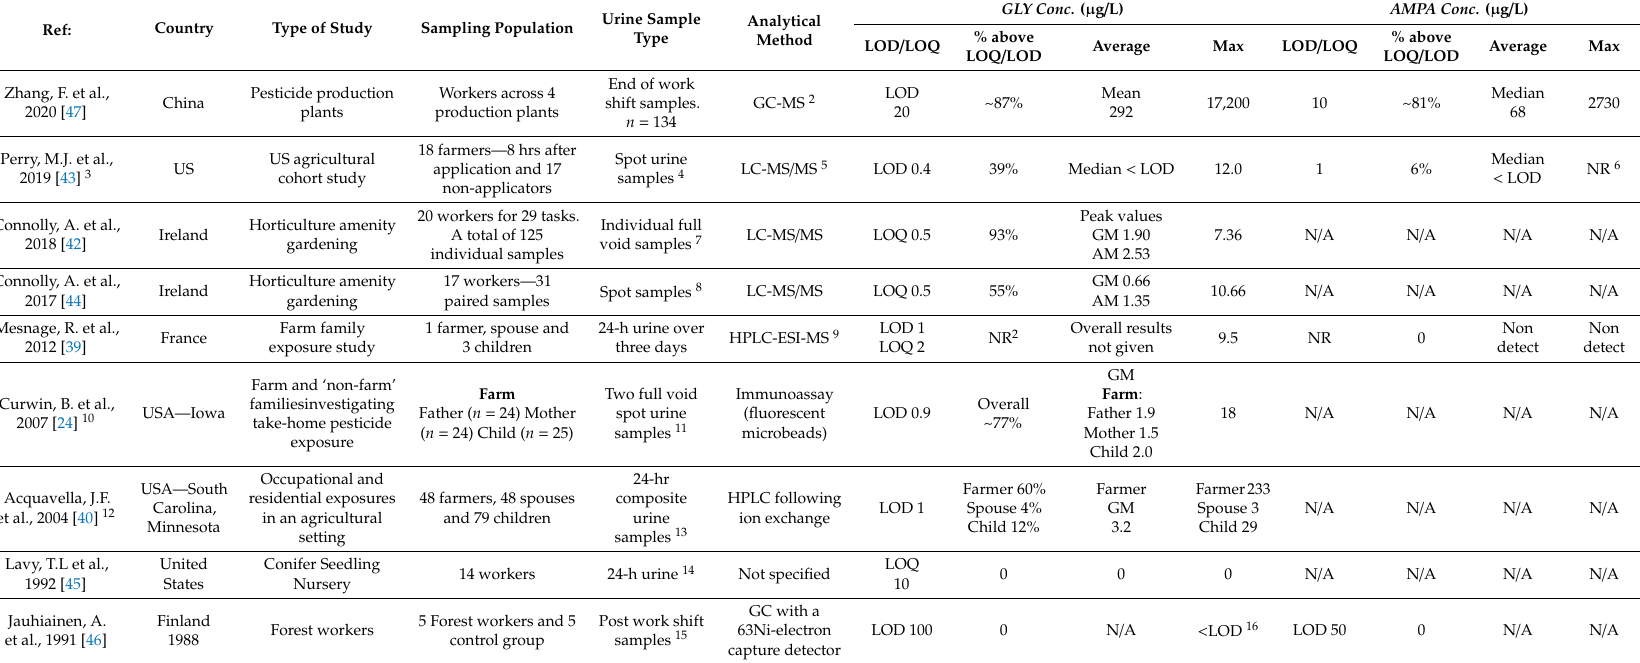
Table 1. Glyphosate (GLY) occupational exposure assessment studies employing biological monitoring methods via urine sampling 1 .